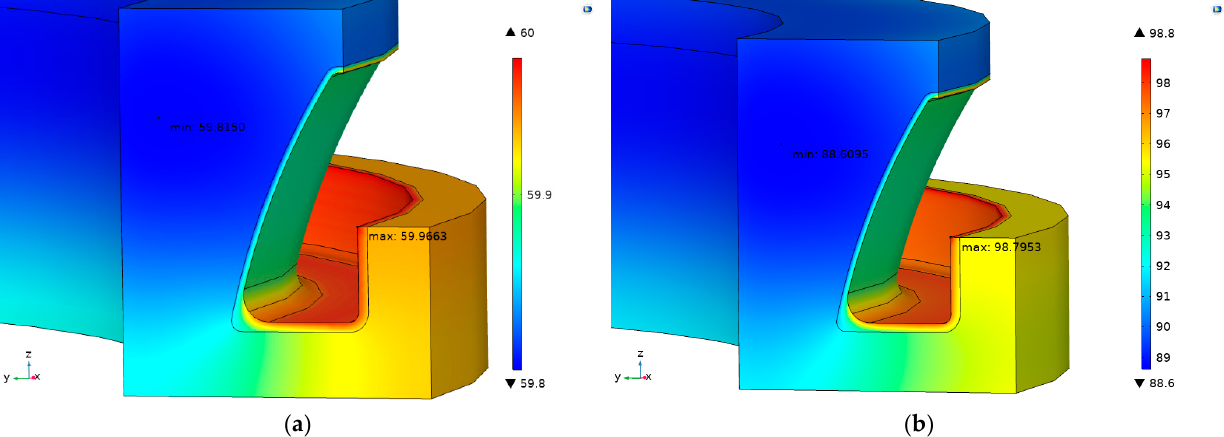
Figure 10. Temperature distribution plot in the part and the mould at the end of dwell phase before the cooling ramp for the curing cycle at ( a ) 60 ◦ C and ( b ) at 100 ◦